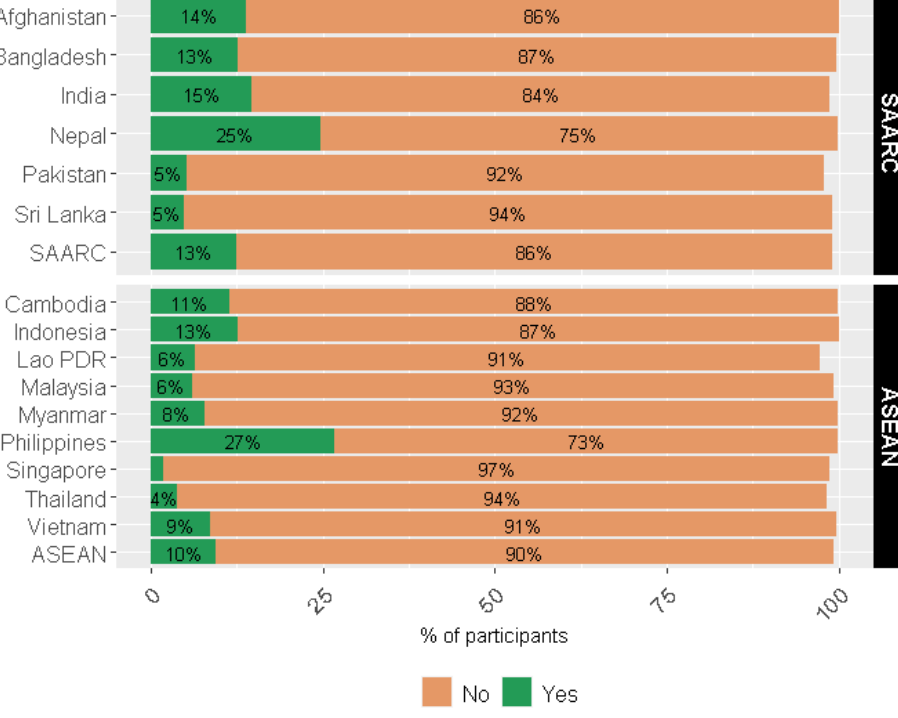
Figure 10. Percentage of participants who borrowed money for medical or health reasons.